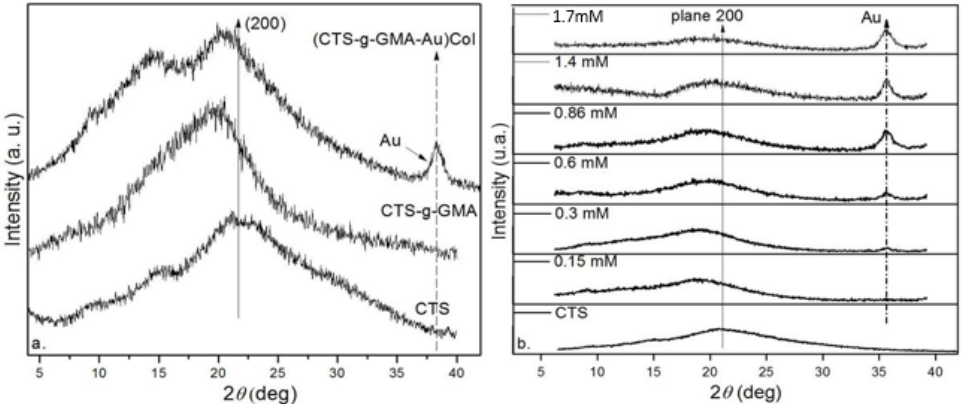
Figure 6. ( a ) CTS diffractograms compared with CTS-g-GMA and (CTS-g-GMA-AuNPs)-Col. ( b ) X-ray diffraction of nanocomposites of chitosan and gold nanoparticles with different concentrations of HAuCl 4 .